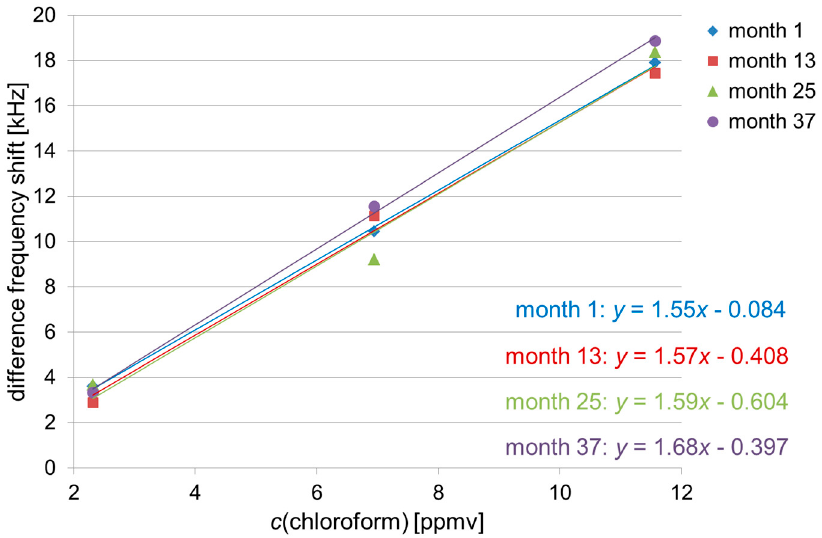
Figure 5. Mean values of sensor 1 (PBMA coating) obtained with chloroform samples at the concentrations of 2.3 ppmv, 6.9 ppmv, and 11.6 ppmv at annual intervals. The lowest and highest concentrations were measured in triplicates, the medium concentration in duplicates. For the sake of clarity, error bars are not included. Regression lines were calculated with y = difference frequency shift [kHz] and x = c (chloroform) [ppmv].